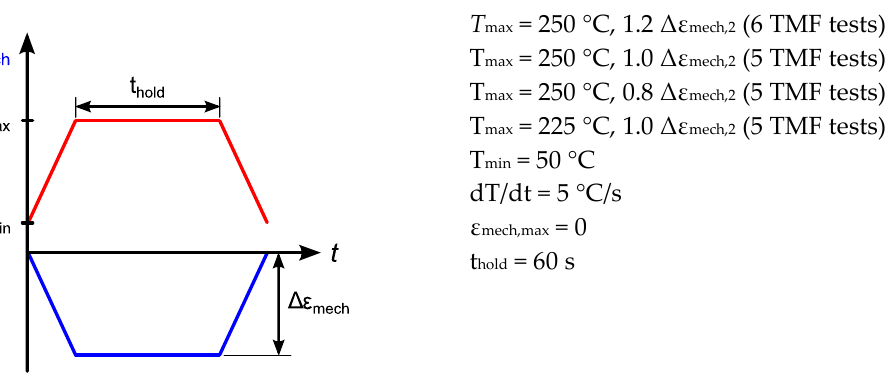
Figure 3. Loading conditions of performed TMF tests.